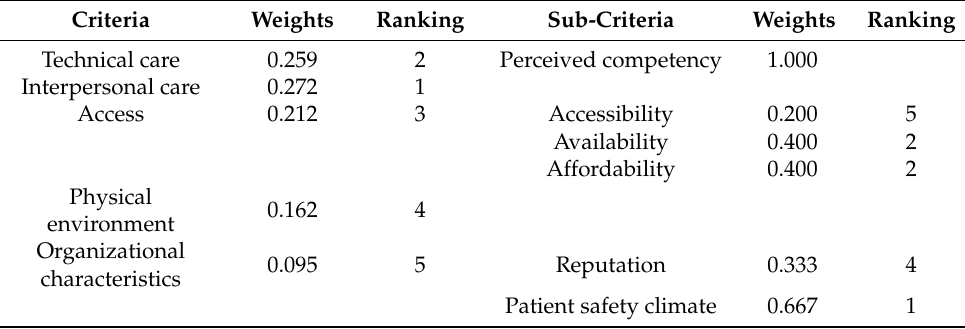
Table 2. The AHP weight and ranking of criteria and